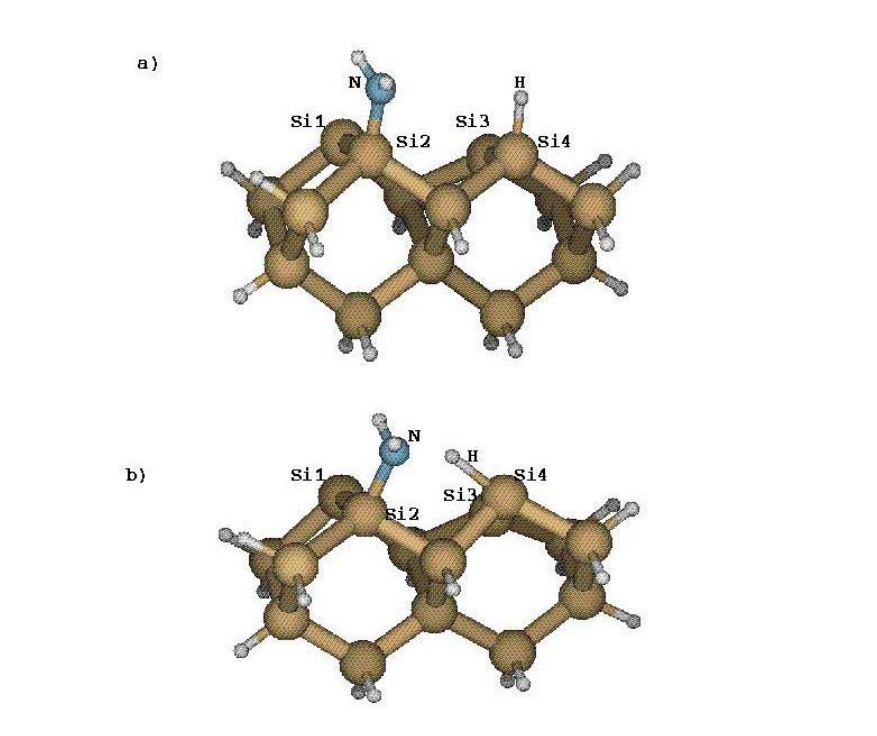
with the H atom on the next silicon dimer, b) 3